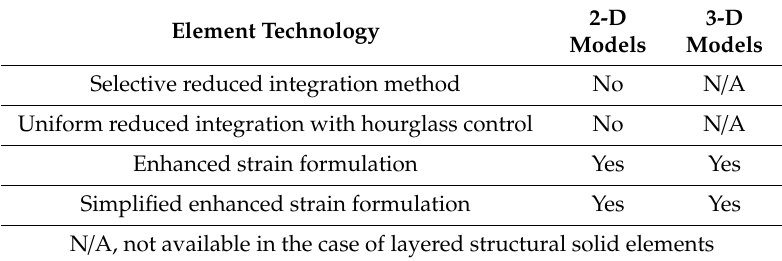
Table 1. Recommendation of the element formulations.